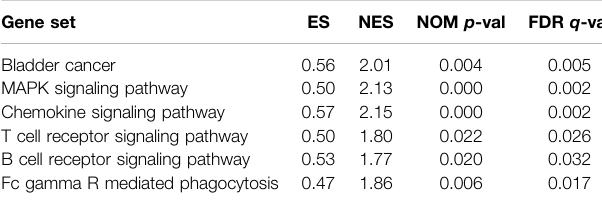
TABLE 2 | The high-risk group enriched gene